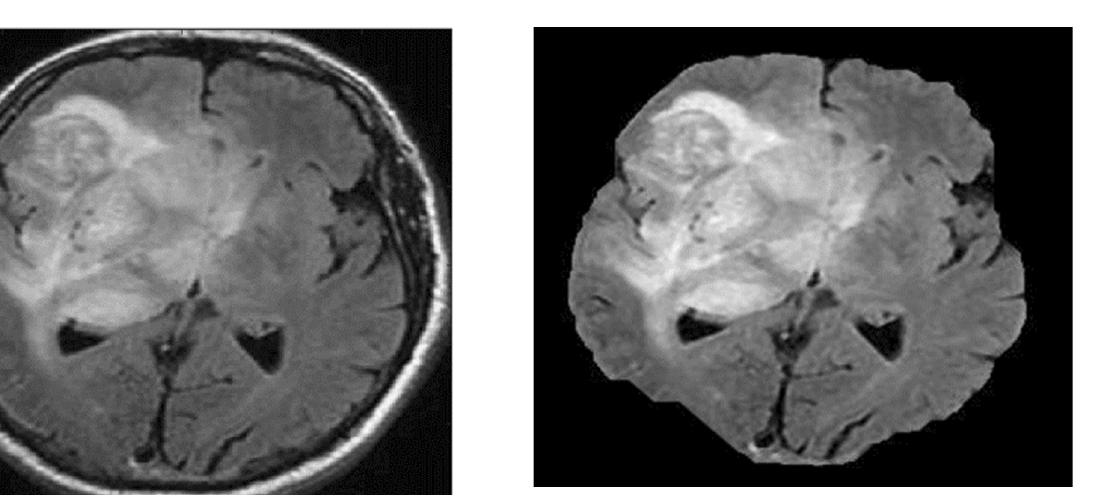
Fig. 4 The result of skull stripping